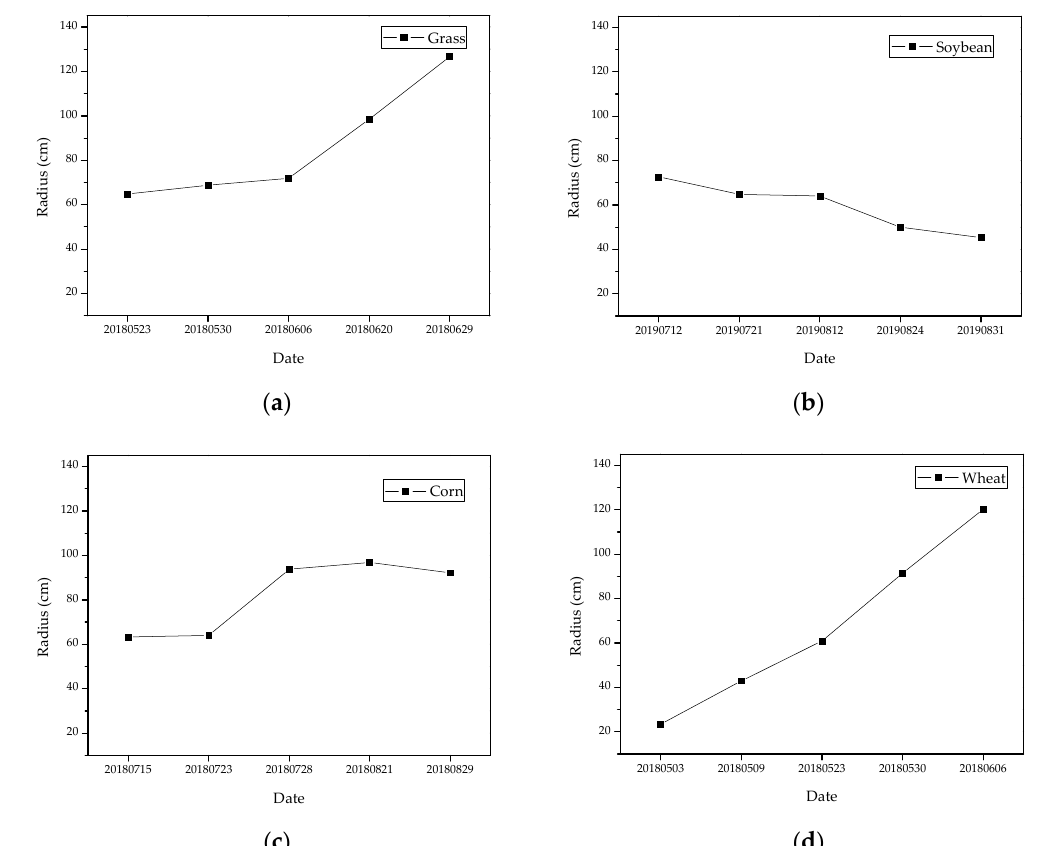
Figure 10. Temporal and spatial variation of stressed vegetation range under natural gas micro- leakage: ( a ) grass; ( b ) soybean; ( c ) corn and ( d ) wheat.